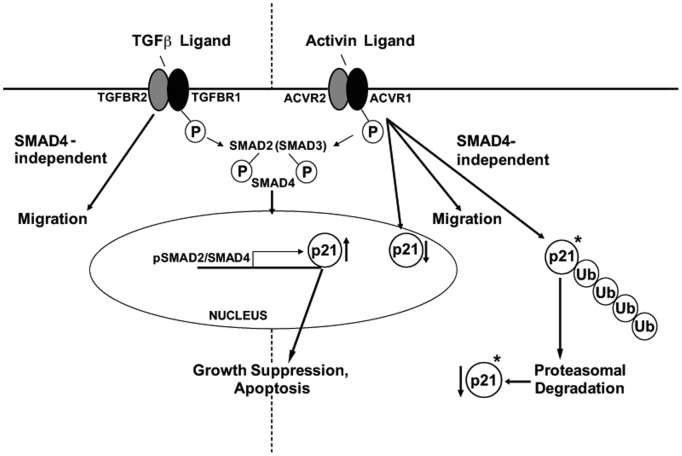
Schematic of proposed differential regulation and effects of activin and TGFβ signaling on p21 in colon cancer cells. * is indicative of total (cytoplasmatic + nuclear) p21.